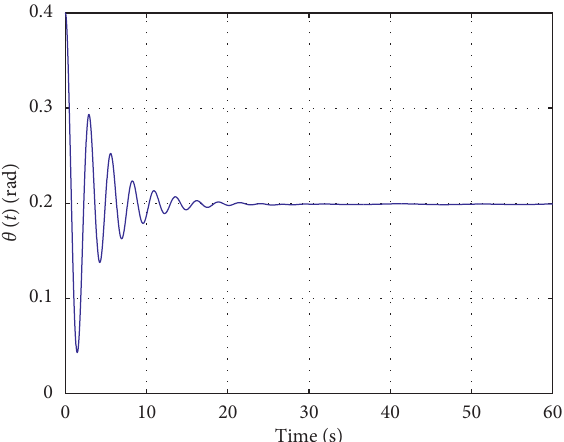
Figure 6: Attitude angle of the spacecraft with adaptive boundary control.